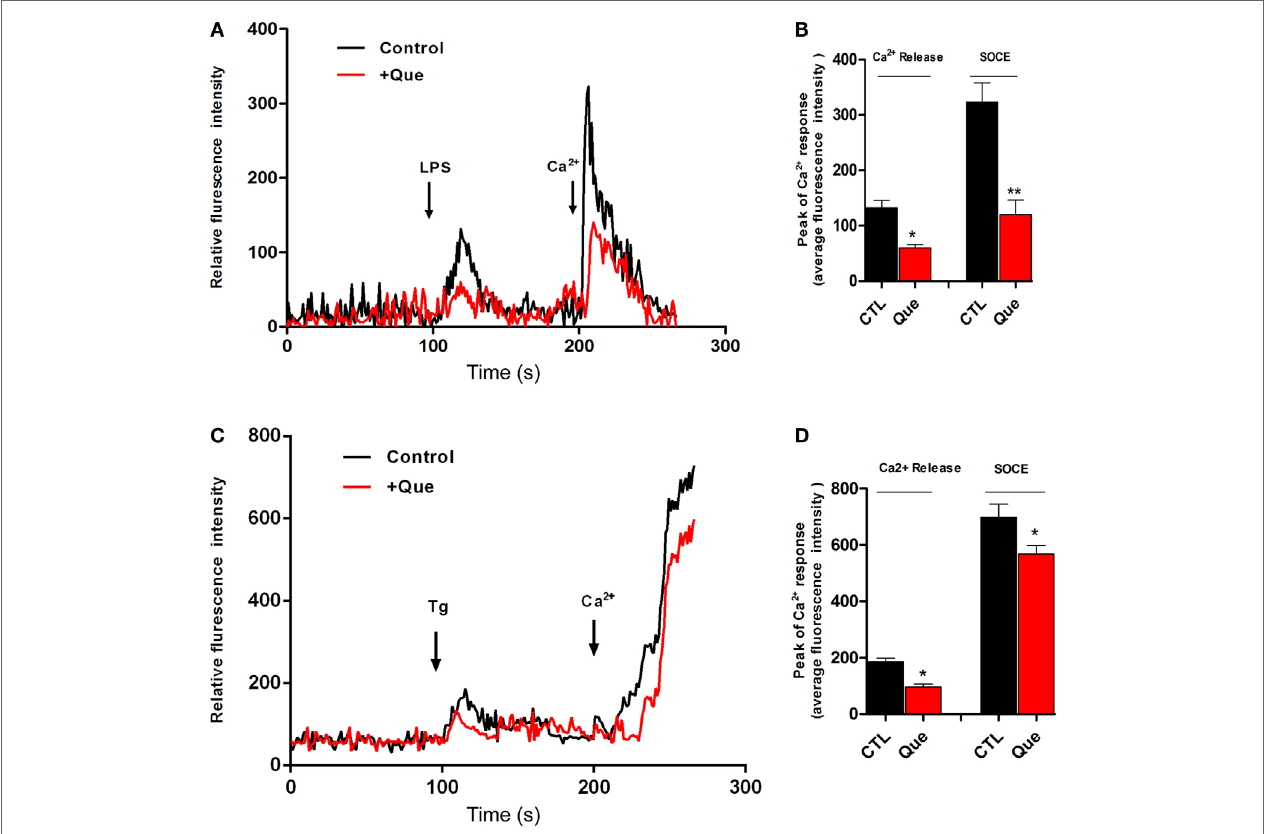
FigUre 3 | effect of Que on ca 2 + release and ca 2 + entry in n9 cells induced by lPs or Tg . (a) Ca 2 + image of N9 cells with LPS stimulation in Ca 2 + -free medium following by Ca 2 + (2 mM) buffer incubation after wash with or without Que (10 μ M) pretreatment. The first peak shows [Ca 2 + ] i elevation due to release of internal ER Ca 2 + induced by LPS; the second peak is due to Ca 2 + influx through the PM, namely ER Ca 2 + store-operated Ca 2 + entry (SOCE). Pretreatment of Que reduces the [Ca 2 + ] i elevation induced by LPS (red) (20–25 cells were analyzed in each group). (B) Quantification of Ca 2 + release (left peak) and store-operated Ca 2 + entry (SOCE) (right peak) in N9 cells activated by LPS with or without Que pretreatment. (c) Ca 2 + image of N9 cells with Tg stimulation in Ca 2 + -free medium following by Ca 2 + (2 mM) buffer incubation after wash with or without Que pretreatment (20–25 cells were analyzed in each group). (D) Quantification of Ca 2 + release (left peak) and store-operated Ca 2 + entry (SOCE) (right peak) in N9 cells activated by Tg with or without Que pretreatment. Values are means ± SEM. * p < 0.05 and ** p < 0.01 vs. CTL.